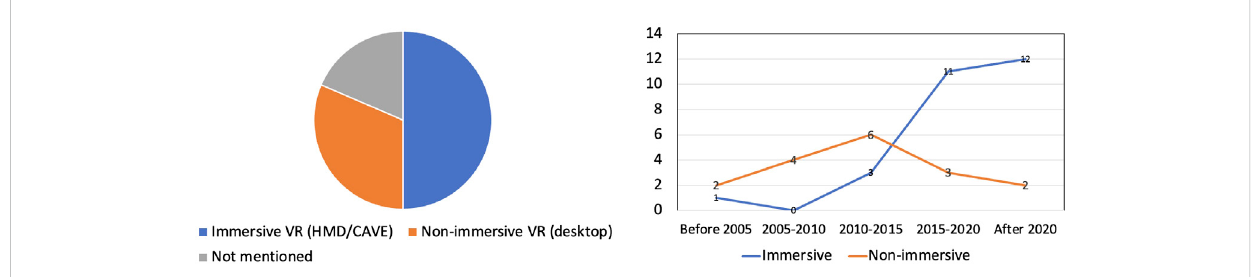
FIGURE 4 Frequency distribution of immersive and non-immersive VR devices used in research (left) and change in quantity by year (right).